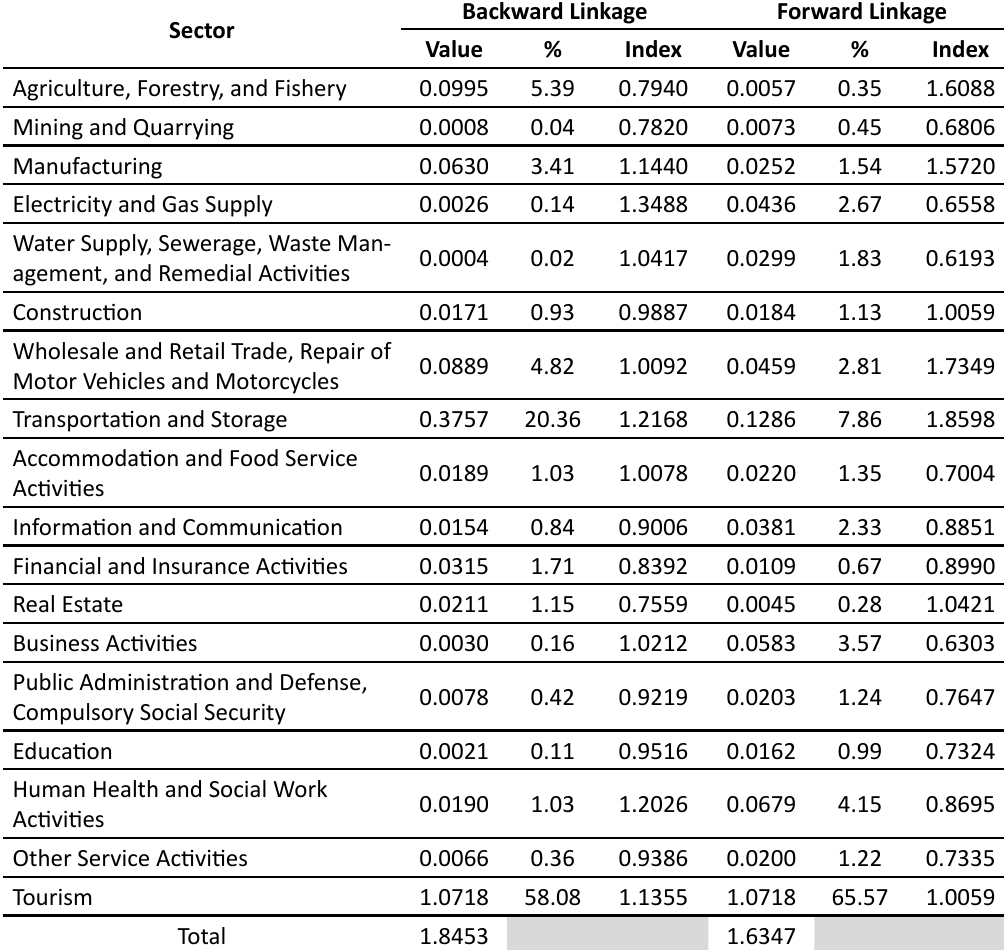
Table 5: Forward Linkage and Backward Linkage by Sector Economic in North